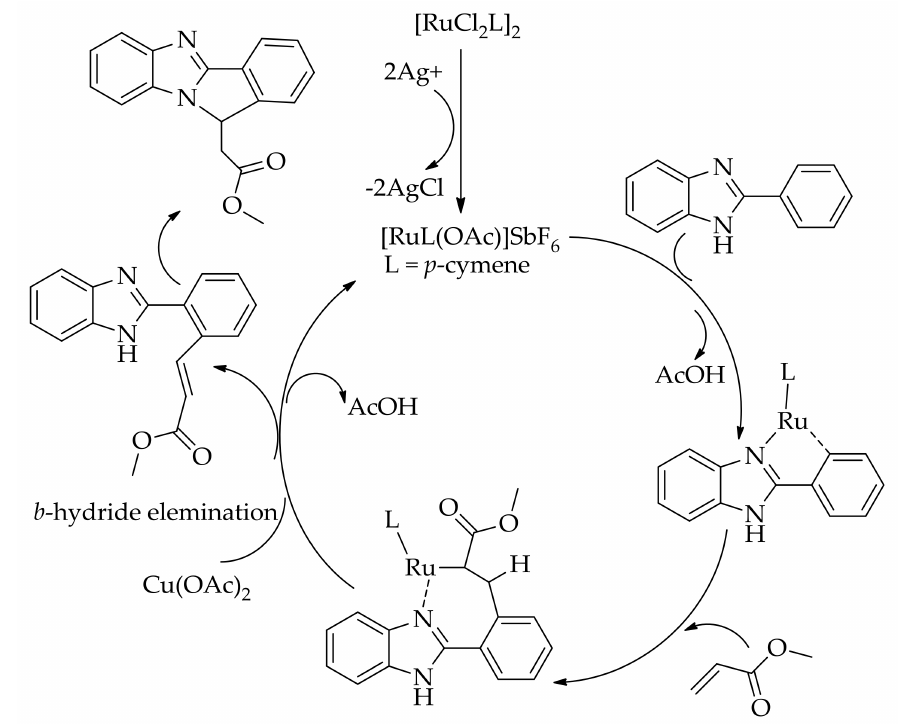
Scheme 47. Proposed mechanism for the formation of benzoimidazoisoindoles